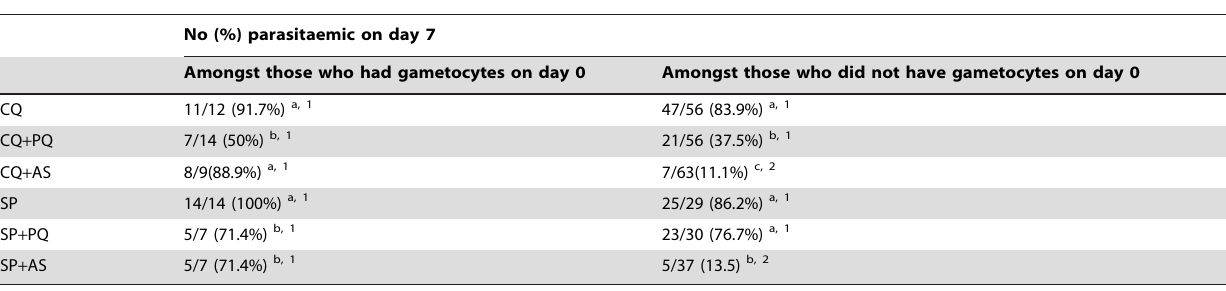
Table 7. Numbers and percentages of individuals with gametocytes on day 7 post treatment.